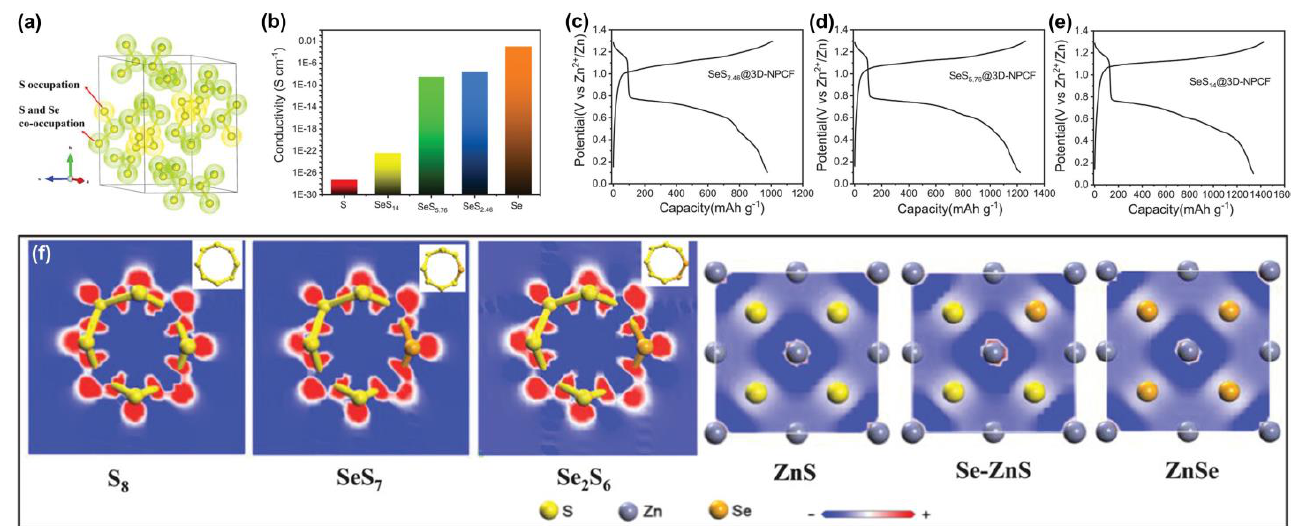
Figure 12. ( a ) Crystal structure of Se x S y (Se 1.1 S 6.9 ); ( b ) conductivities of different Se x S y ; ( c – e ) GCD curves of different Se x S y cathodes at 0.2 A g −1 ; ( f ) electron density differences for different charge and discharge products (reproduced with permission from Ref. [99]. Copyright 2021, Wiley-VCH).